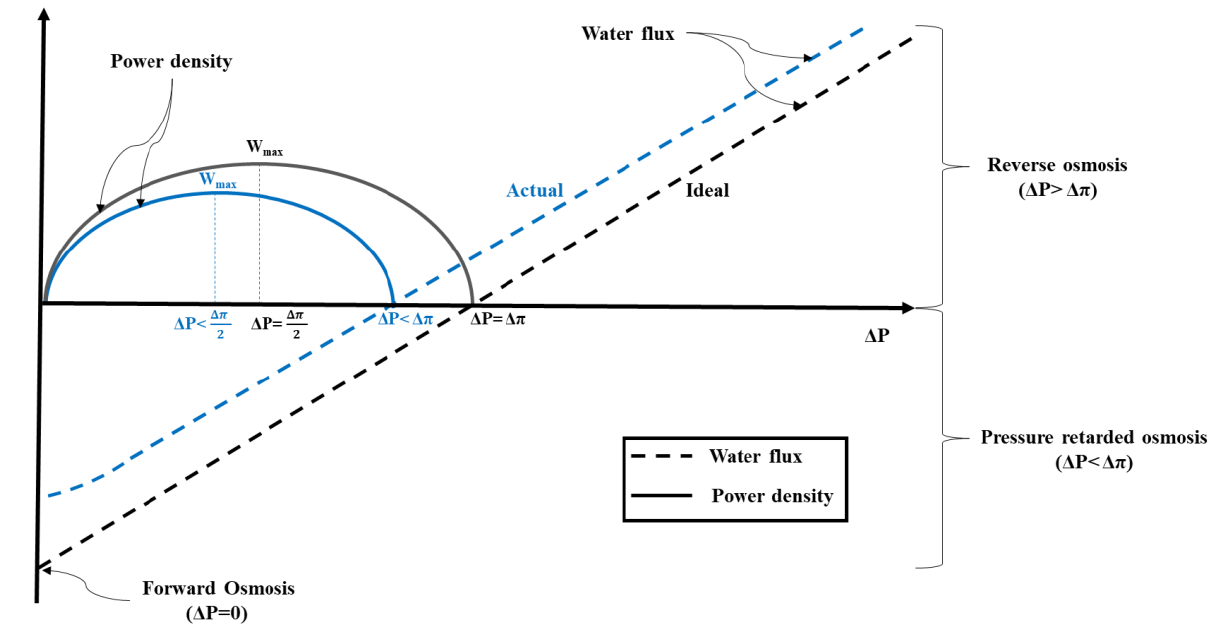
Figure 2. Variations in water flux with hydraulic pressure difference for FO, RO, and PRO processes, as well as changes in power density for PRO.